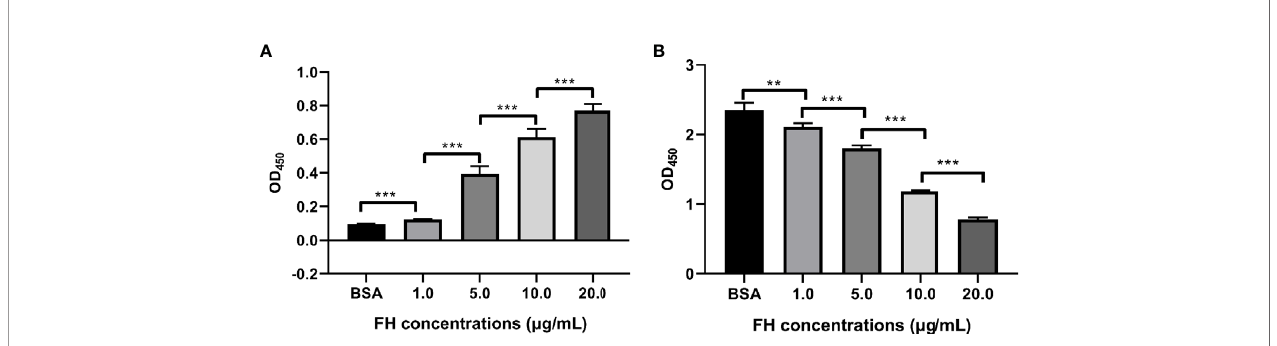
FIGURE 5 | FH recruitment decreased the C3b deposition on ExPEC. Bacteria pre-incubated with puri fi ed human FH (1.0, 5.0, 10, or 20 m g/ml) or BSA, and incubated with 10% FH-depleted human serum. The FH recruitment levels (A) and the C3b deposition levels (B) were detected by ELISA. The data are expressed as the mean ± SEM of three independent experiments. The statistical signi fi cance of differences between each pair was determined using the unpaired t test (** p < 0.01; *** p < 0.001; ns, no signi fi cance).